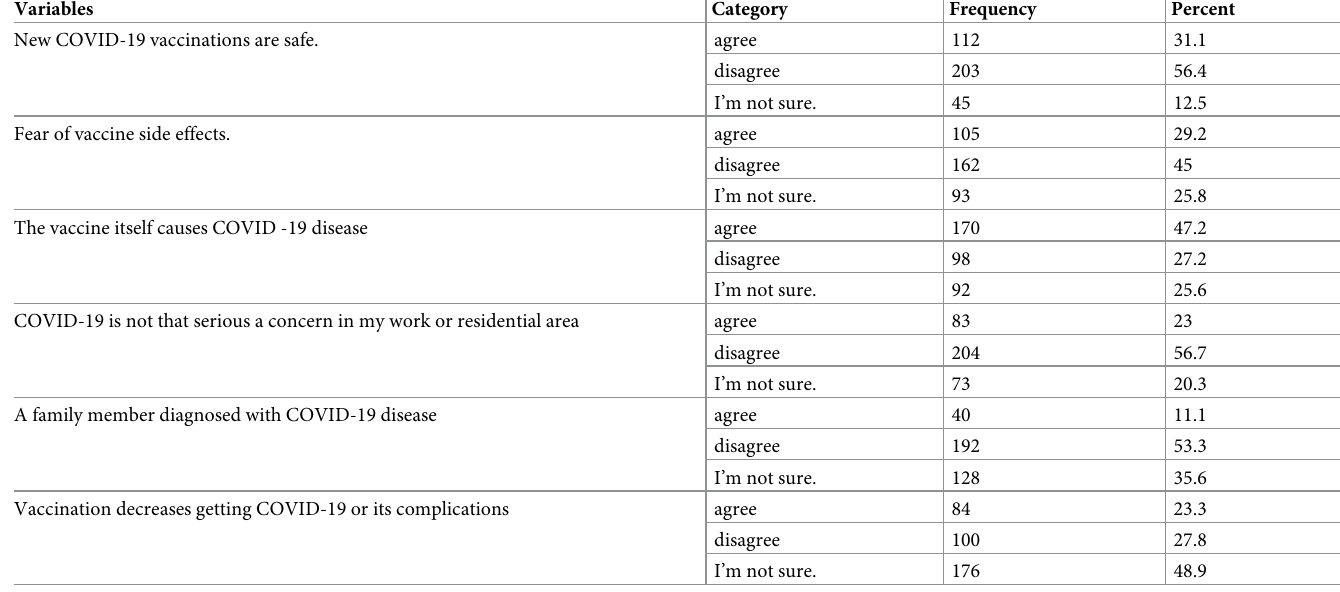
Table 2. Distribution of respondents’ frequency concerning their attitude toward the COVID-19 vaccine at Gurage Zone 2021. Variables Category New COVID-19 vaccinations are safe.